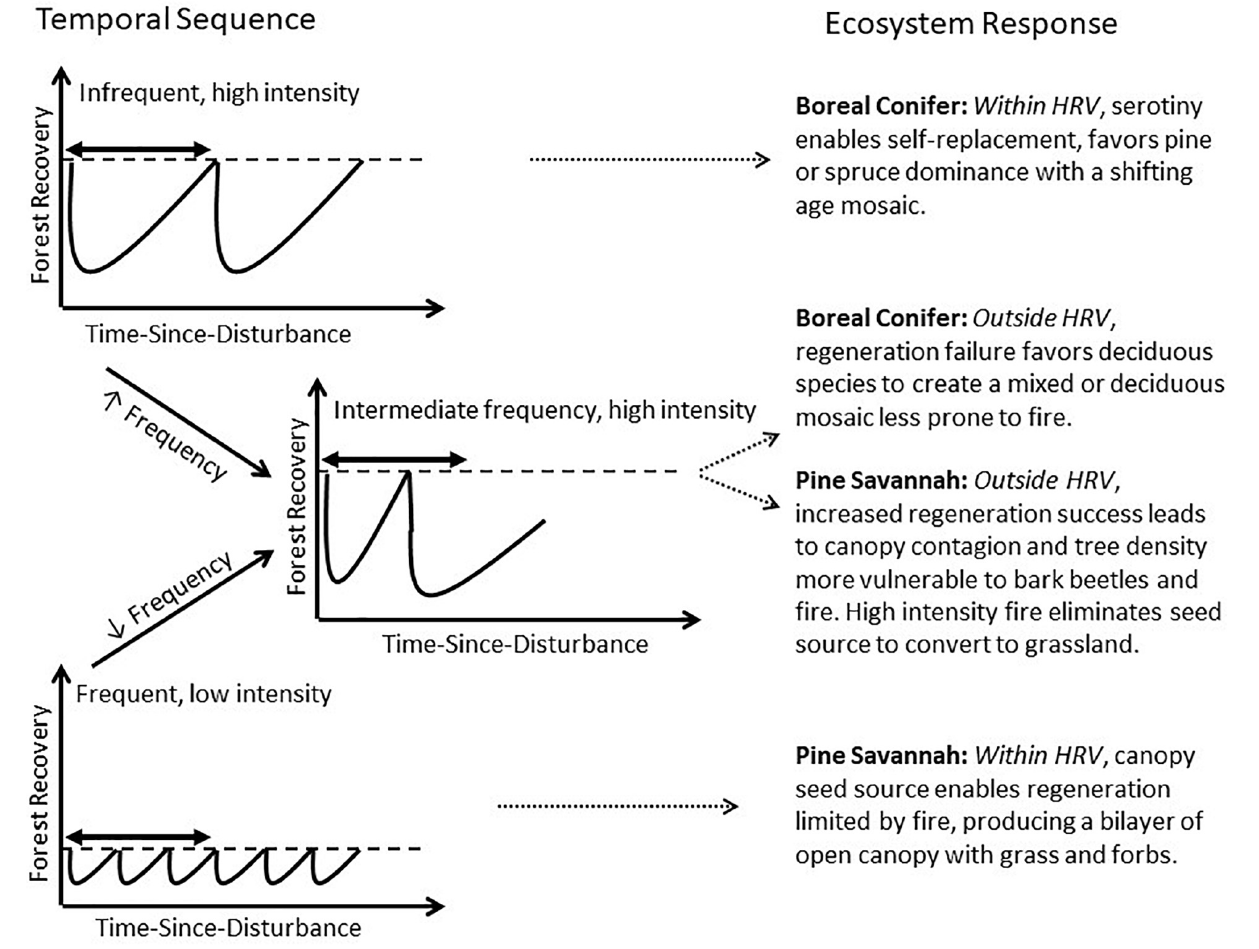
FIGURE 4 | Compound disturbances are those affecting system recovery (i.e., resilience), where the Historic Range of Variability (HRV) serves as the context for ecosystem resilience. By example, serotinous boreal conifers are adapted to high intensity crown fire but require sufficient time to develop a canopy seed bank. Non-serotinous pines often require frequent fire to dampen regeneration to maintain open savannah structure. Fire frequencies intermediate to these extremes can consume the seed producing potential in either system, leading to a conversion to new systems (see text for